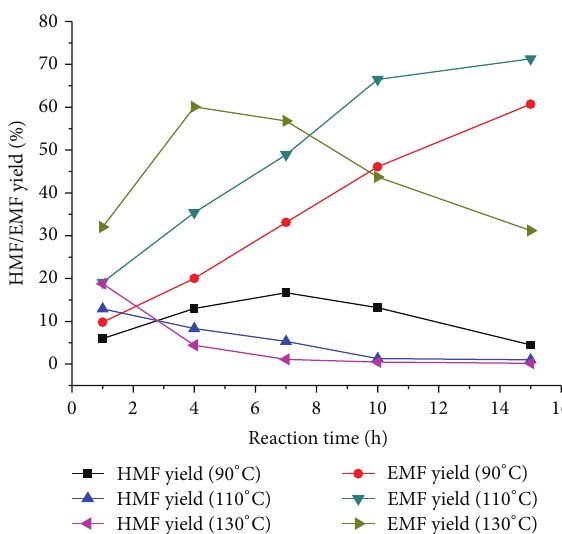
Figure 3: NH 3 -TPD profiles of sample powders.